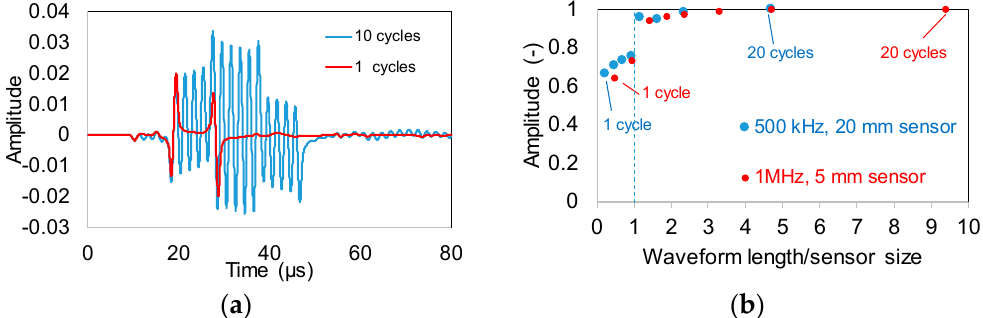
Figure 15. ( a ) Simulated waveforms received by 20 mm size sensor after surface source excitation with frequency of 500 kHz and different number of cycles; ( b ) Relative amplitude vs. waveform length over sensor size.